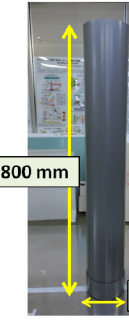
Figure 4. Photograph of